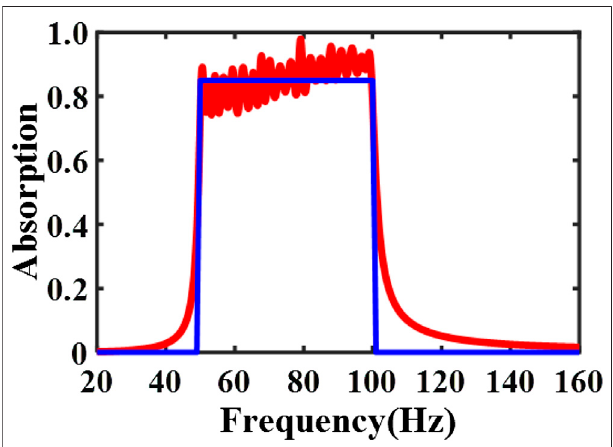
FIGURE 8 | The absorption coef fi cient of the optimized supercell (red solid line) and the ideal absorber (blue solid line) at normal incidence. The optimal thickness for theoptimized design is20 cm. The optimal thickness for the ideal design is 16.9 cm when the volume porosity is set as one and theachievedabsorptionspectrumexactlymatcheswiththedesiredone(85% over 50 – 100 Hz) in Eq. 7